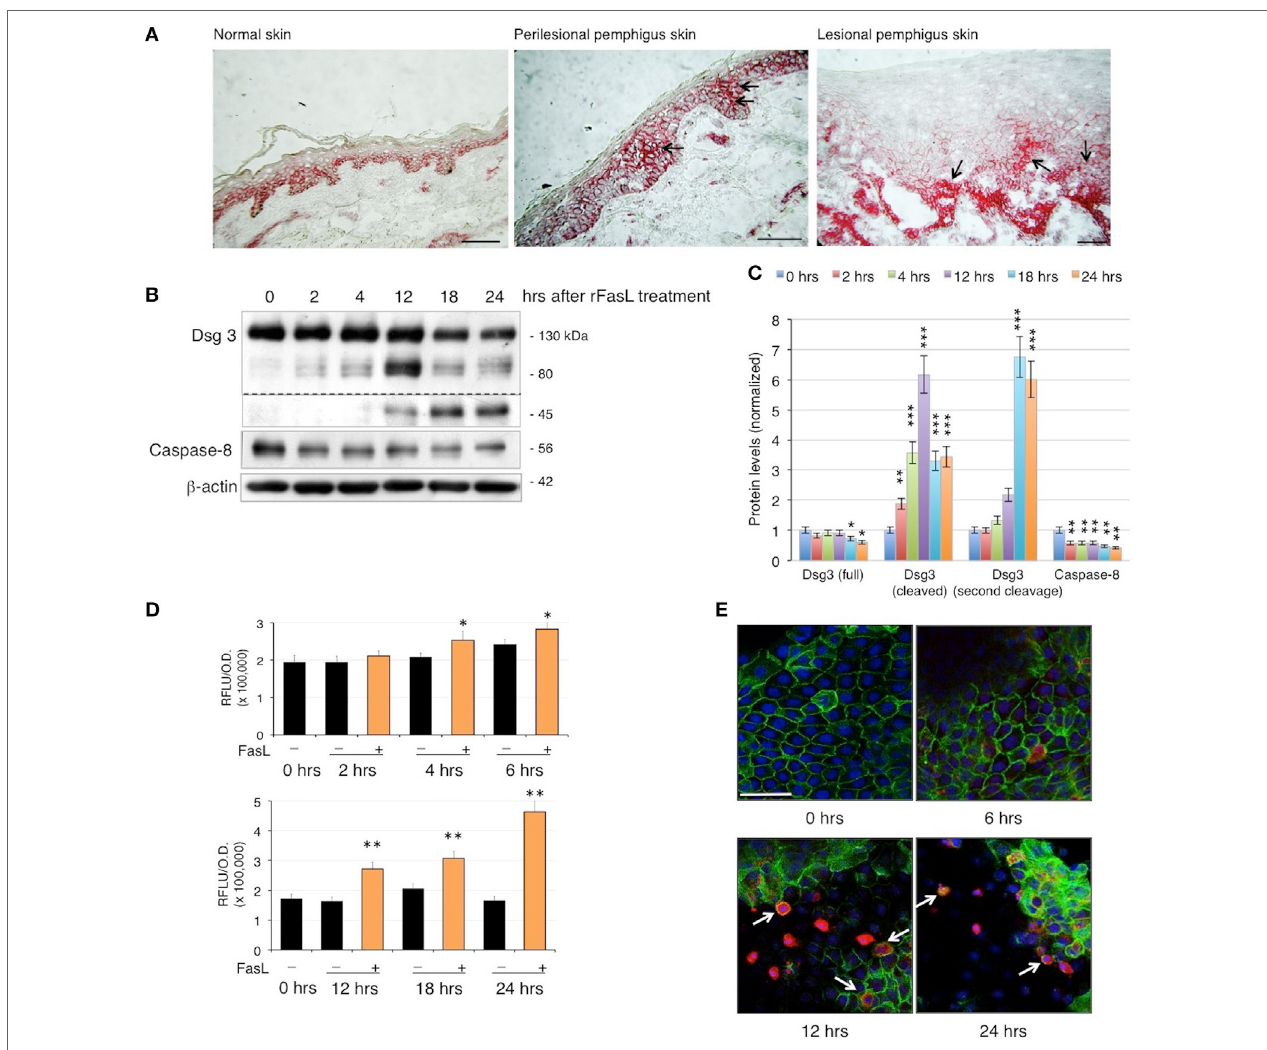
FigUre 1 | Fas ligand (FasL)-induced apoptosis precedes acantholysis in human keratinocytes: (a) Fas is upregulated in pemphigus skin before cell detachment. Cryosections from normal human skin, perilesional, and lesional pemphigus skin were methanol-fixed and stained with anti-Fas antibody (arrows), scale bar: 100 µm. (B–e) rFasL induces desmoglein (Dsg)3 cleavage through caspases activation in a time-dependent manner. Differentiated keratinocyte monolayers were treated with 50 ng/ml of recombinant soluble FasL (rFasL) for different time points. Cell lysates were (B) immunoblotted and (c) protein amounts were quantified (means ± SEM; * P < 0.05; ** P < 0.01; *** P < 0.001 per Student’s t -test vs cntrl; n = 5 independent experiments). Dsg3 (full), 130 kDa; Dsg3 (cleaved), 80 kDa; Dsg3 (second cleavage), 45 kDa. (D) Caspase-3/7 activity was measured at each time point in the presence ( + , orange bars) or absence ( − , black bars) of